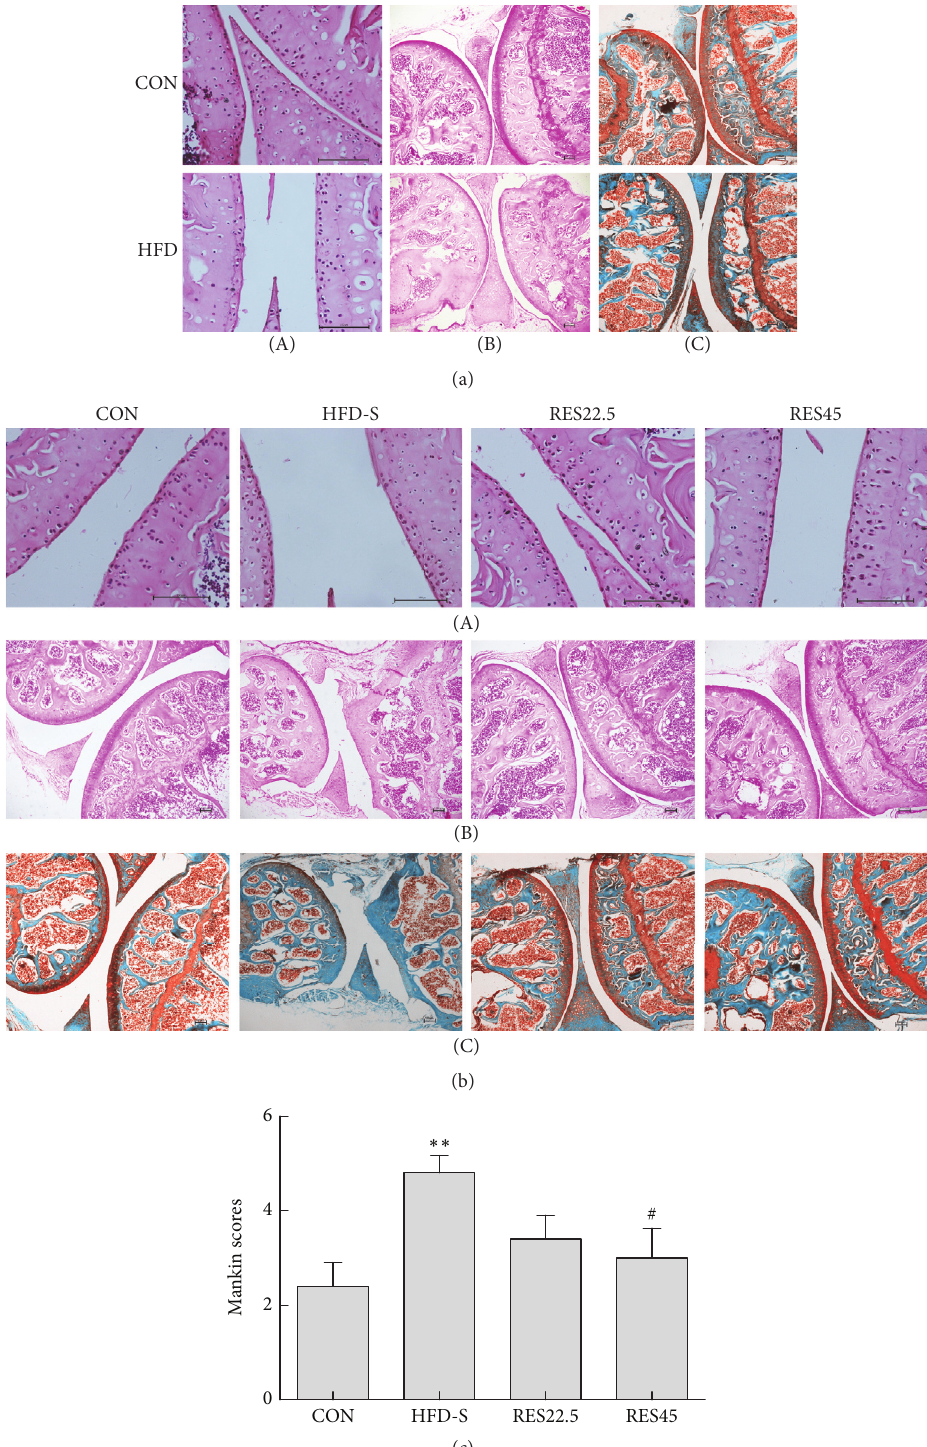
Figure 2: Oral resveratrol prevents articular cartilage damage in a HFD induced OA model. (a) Articular staining of mice fed with HFD at the end of 16 weeks (CON and HFD, 𝑛 = 2 ). (b) Articular staining of mice after resveratrol treatment at the end of 28 weeks ( 𝑛 = 5 per group); (A) H & E (original magnification, 200x); (B) Safranin O (original magnification, 40x); and (C) Safranin O/Fast Green (original magnification, 40x). (c) Modified Mankin scores. Scale bars = 100 𝜇 m. One-way ANOVA was used to test for statistical significance. Data were expressed as the mean ± SEM. ∗∗ 𝑃 < 0.01 , versus the CON group; # 𝑃 < 0.05 versus the HFD-S